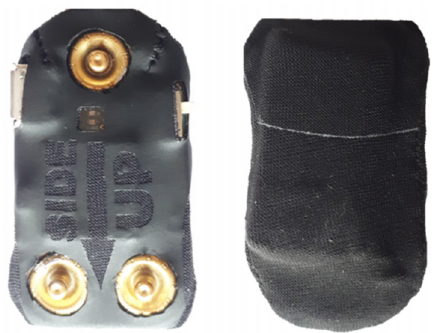
Figure 6. Hardware inertial unit coated with a slim, resistant textile.